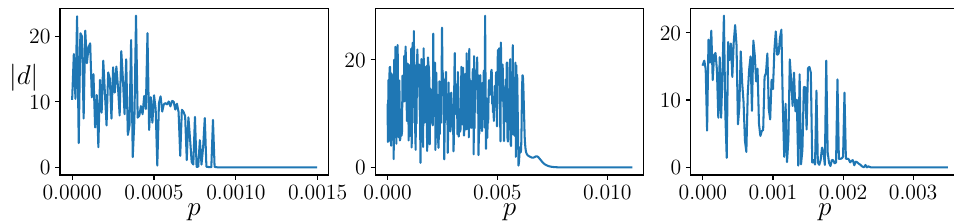
Figure 2. Asymptotic distance d as a function of the coupling strength p for different coupling directions. From left to right: C = [ 1,1,1 ] , C x = [ 1,0,0 ] , C y = [ 0,1,0 ]